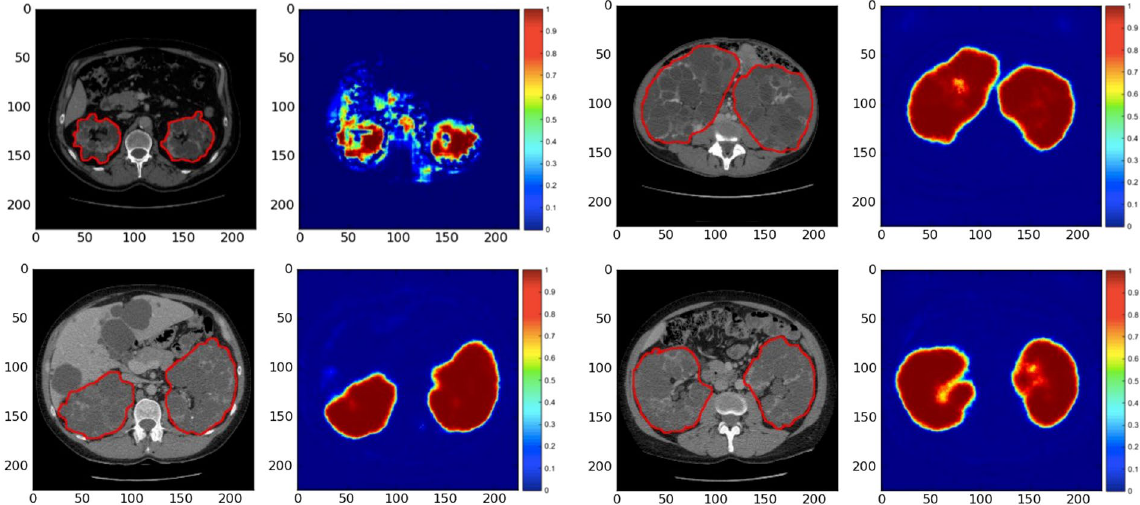
Figure 2. CNN predictions of ADPKD Kidneys. Four segmentations (red contour) of ADPKD kidneys from CT acquisitions of different patients are shown. The corresponding CNN-generated probability maps are shown in pseudo